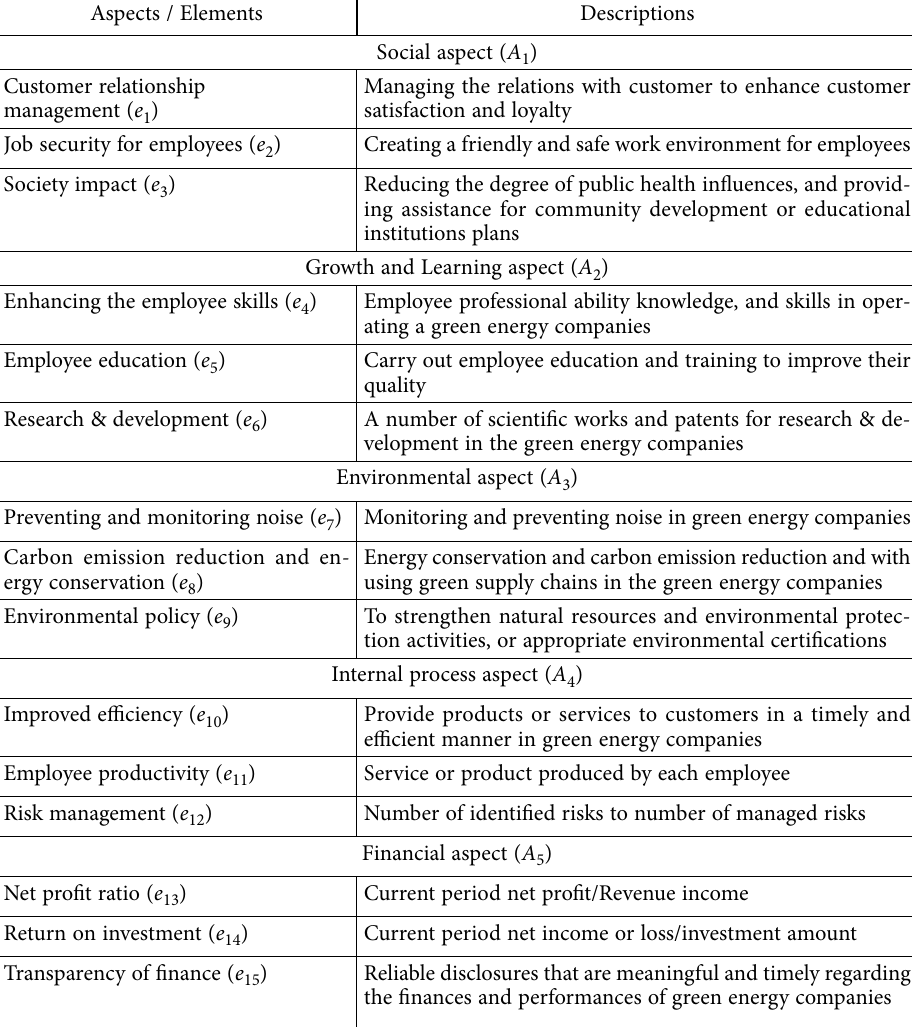
Table 1. Clarification of aspects and